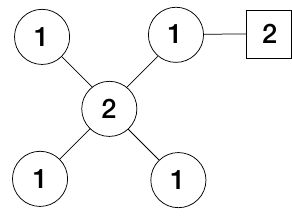
Figure 2 . Doubly framed b D 4